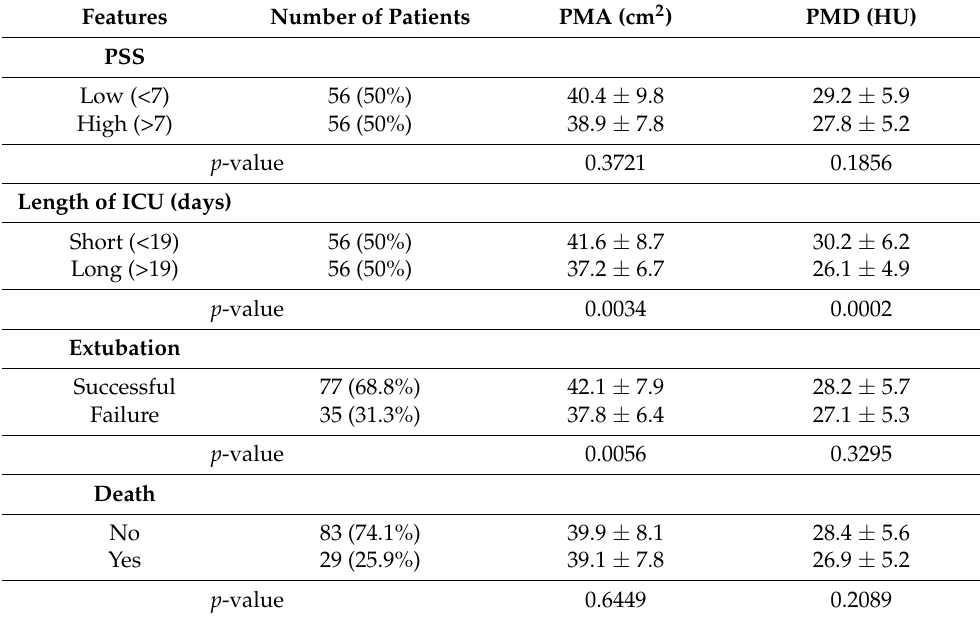
Table 2. CT-derived muscle analysis comparison in clinical and radiological features.